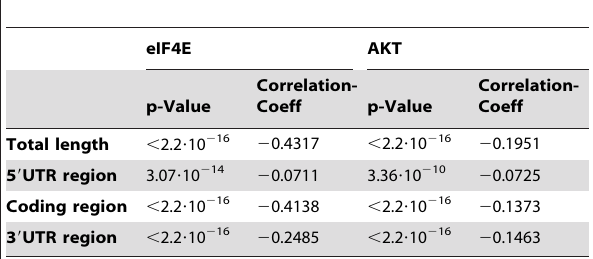
Table 2. Length correlates with fold shift for total, coding and 3 9 UTR but not 5 9 UTR of target mRNAs.